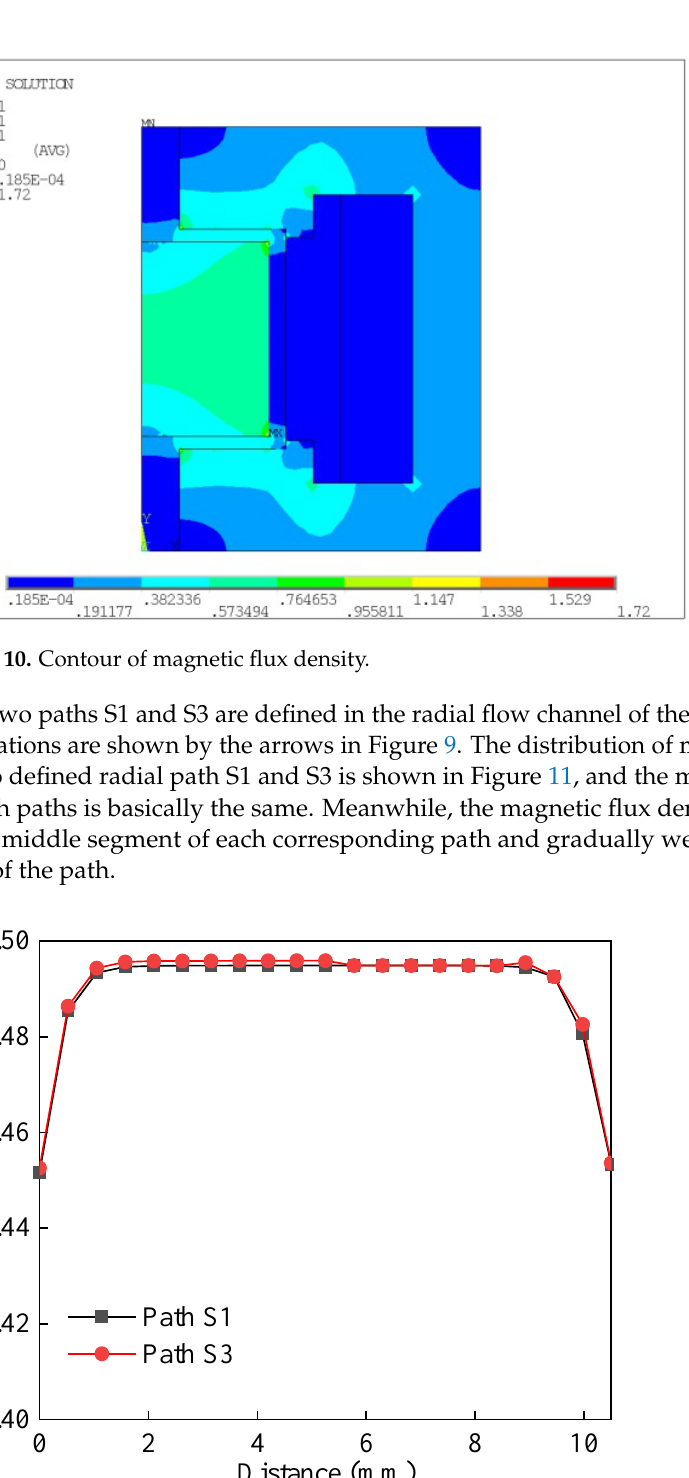
Figure 9. Distribution of magnetic flux lines.